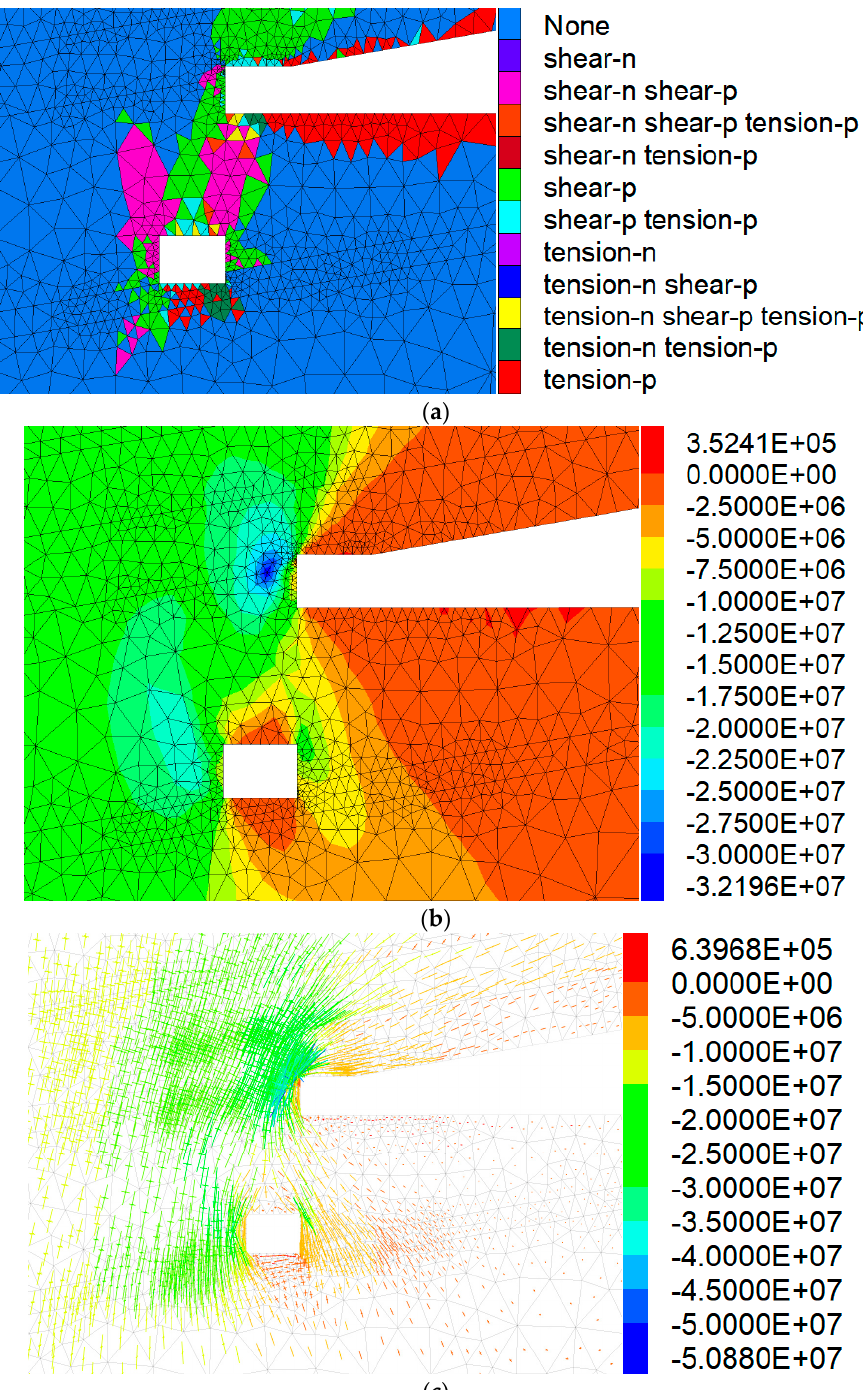
Figure 10. Surrounding rock stability with zero pillar. ( a ) Plastic zone; ( b ) Abutment vertical stress distribution; ( c ) Principal stress distribution.